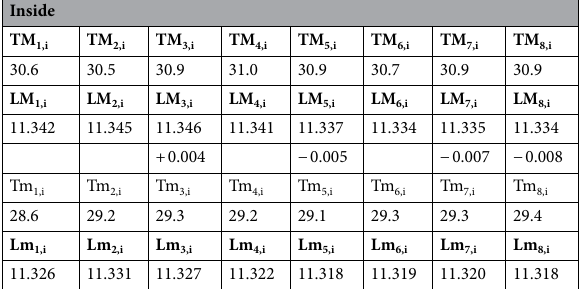
Table 2. Values of relative maxima and minima of the curves in Fig. 2b.